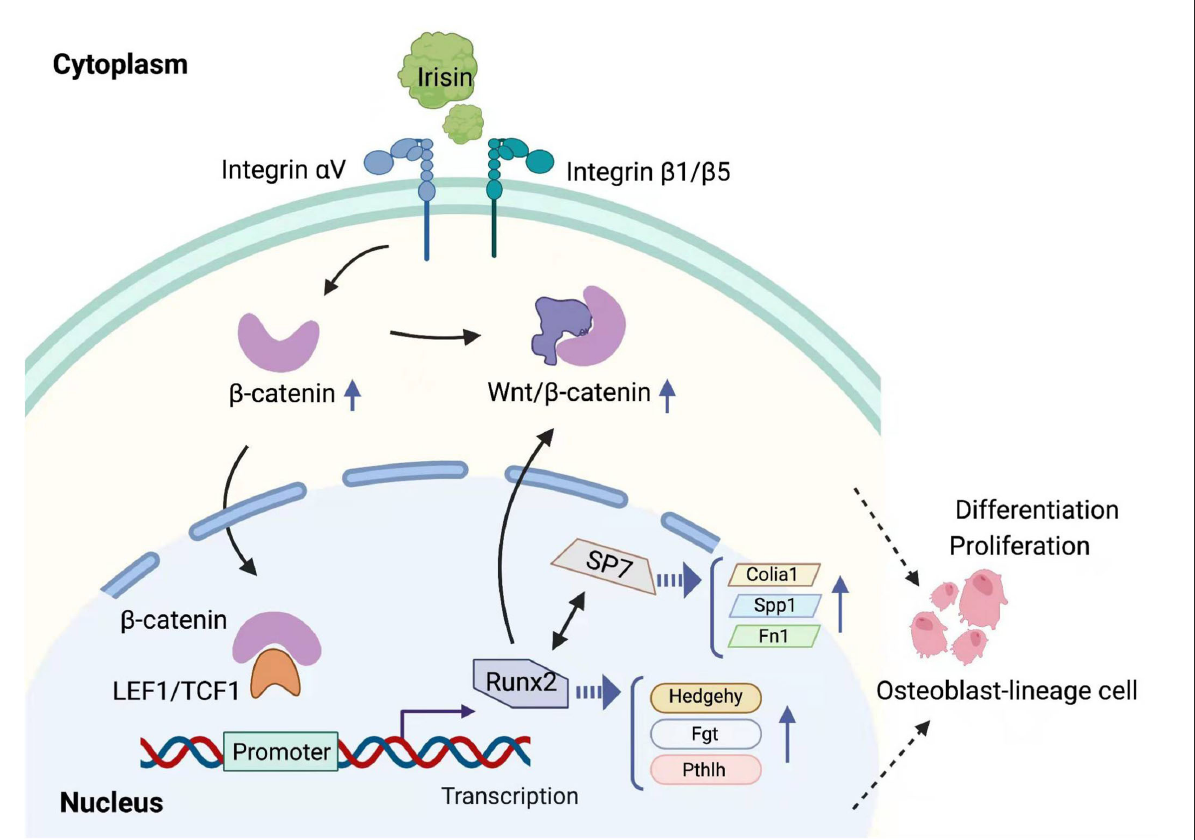
FIGURE3 Mechanisms of regulation of the Wnt/ β -catenin pathway by irisin in osteogenic lineage cells. Irisin affects various steps of the Wnt/ β -catenin pathway by binding to integrins and causing the accumulation of intracellular β